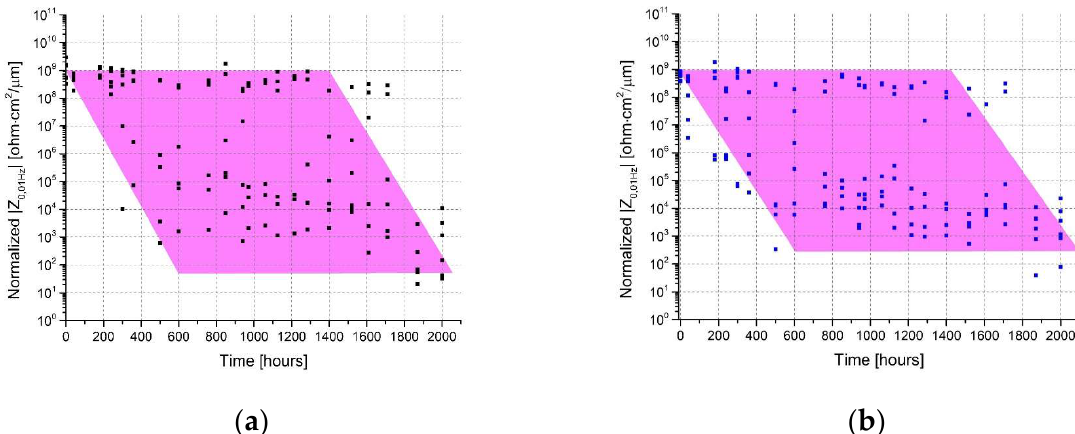
Figure 3. Impedance modulus at low frequencies (0.01 Hz) of painted steel ( a ) and HDG steel ( b ) samples vs. aging time in NSST.